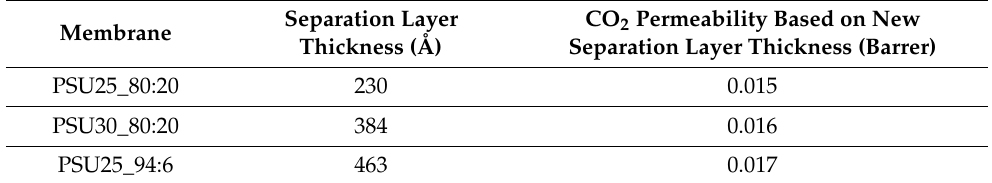
Table 4. Calculated separation layer thickness in asymmetric PSU flat sheet